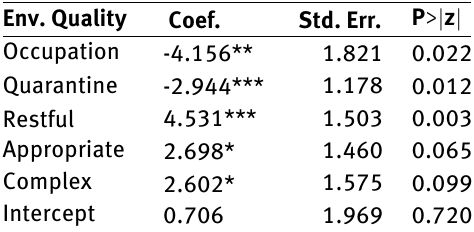
Table 2: Coefficients of the model for environmental quality. Env. Quality